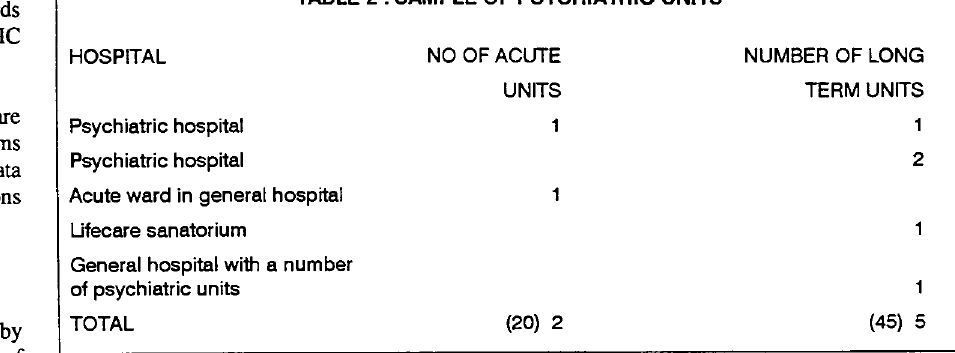
TABLE 2 : SAMPLE OF PSYCHIATRIC UNITS